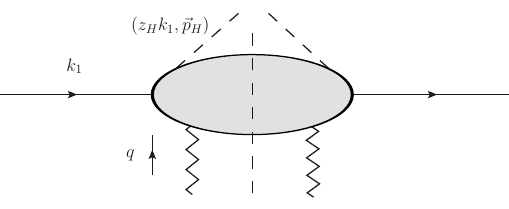
Figure 4 . Schematic description of the Higgs impact factor: z H is the fraction of longitudinal momentum of the initial parton carried by the outgoing Higgs and ~p